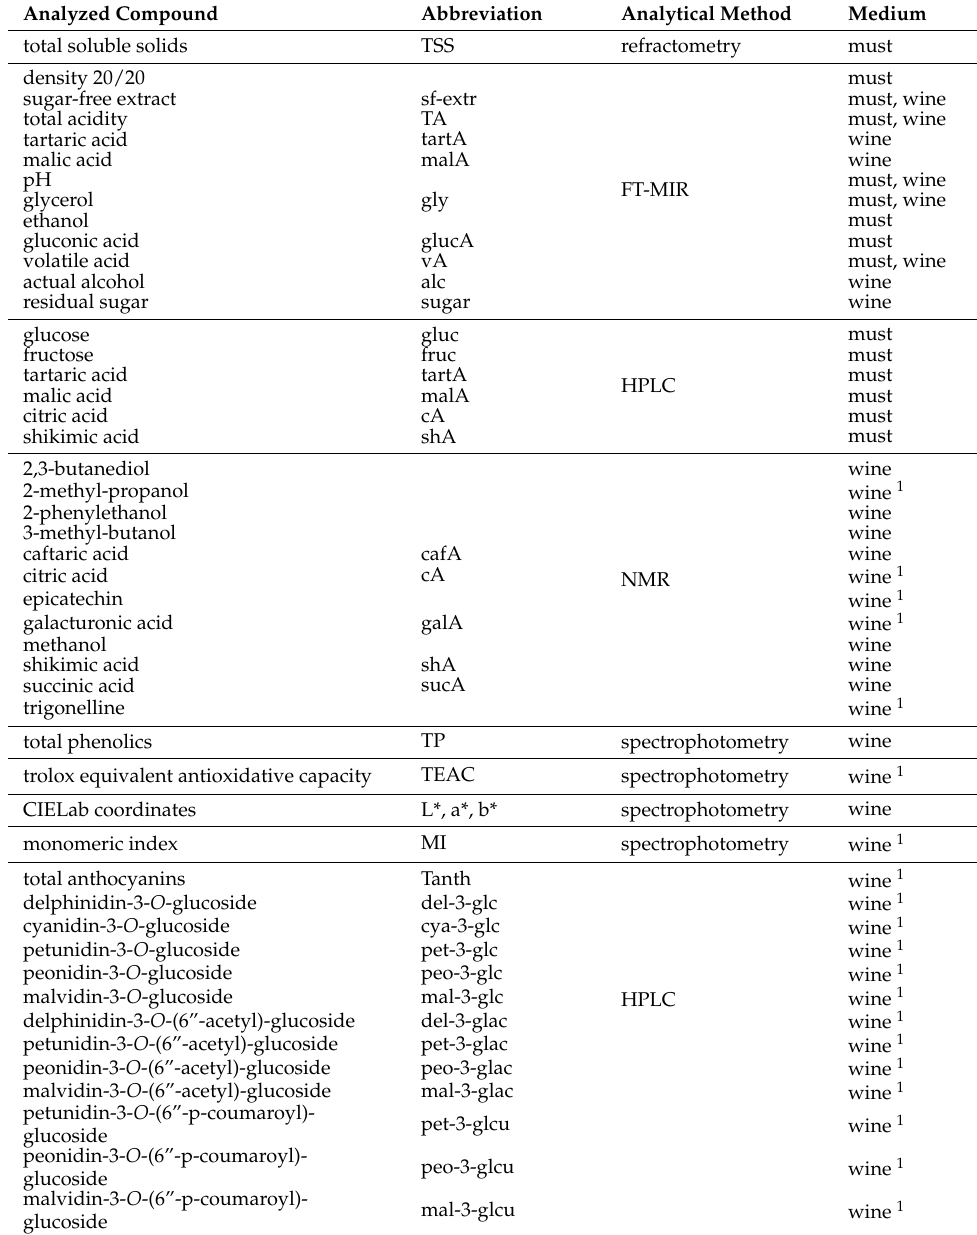
Table 1. Investigated compounds subdivided by analytical